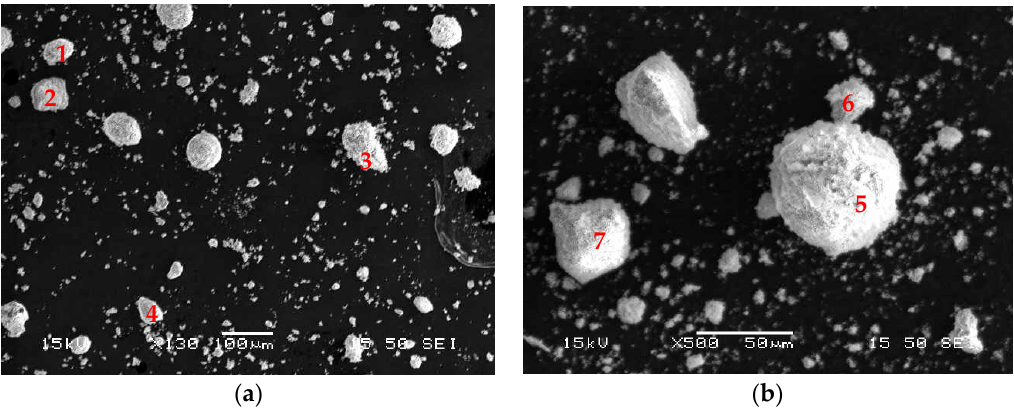
Figure 17. SEM mineral identifications in MgO, Na 2 CO 3 and bauxite residue ( a ) sinter products; (1)